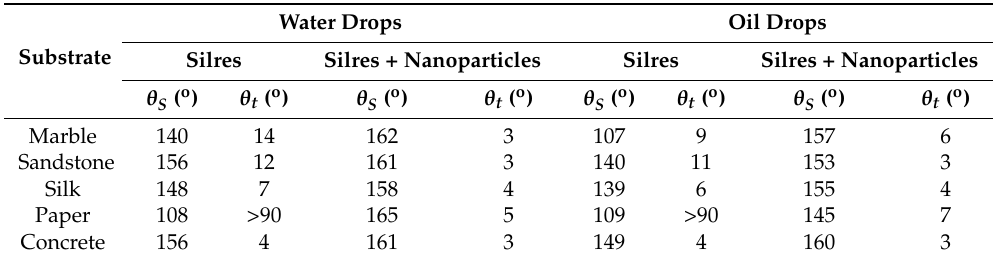
Table 1. Static ( θ S ) and tilt ( θ t ) contact angles of water and oil drops on Silres and Silres + nanoparticles coatings which were deposited on various substrate